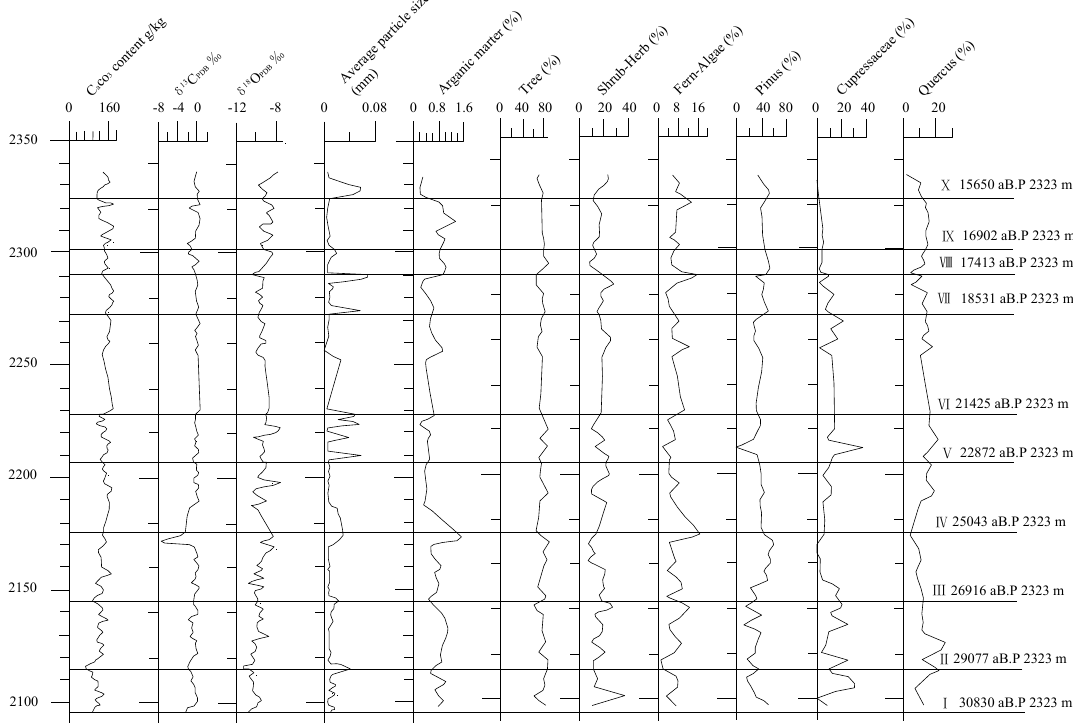
climate, while the low value means humid climate. As